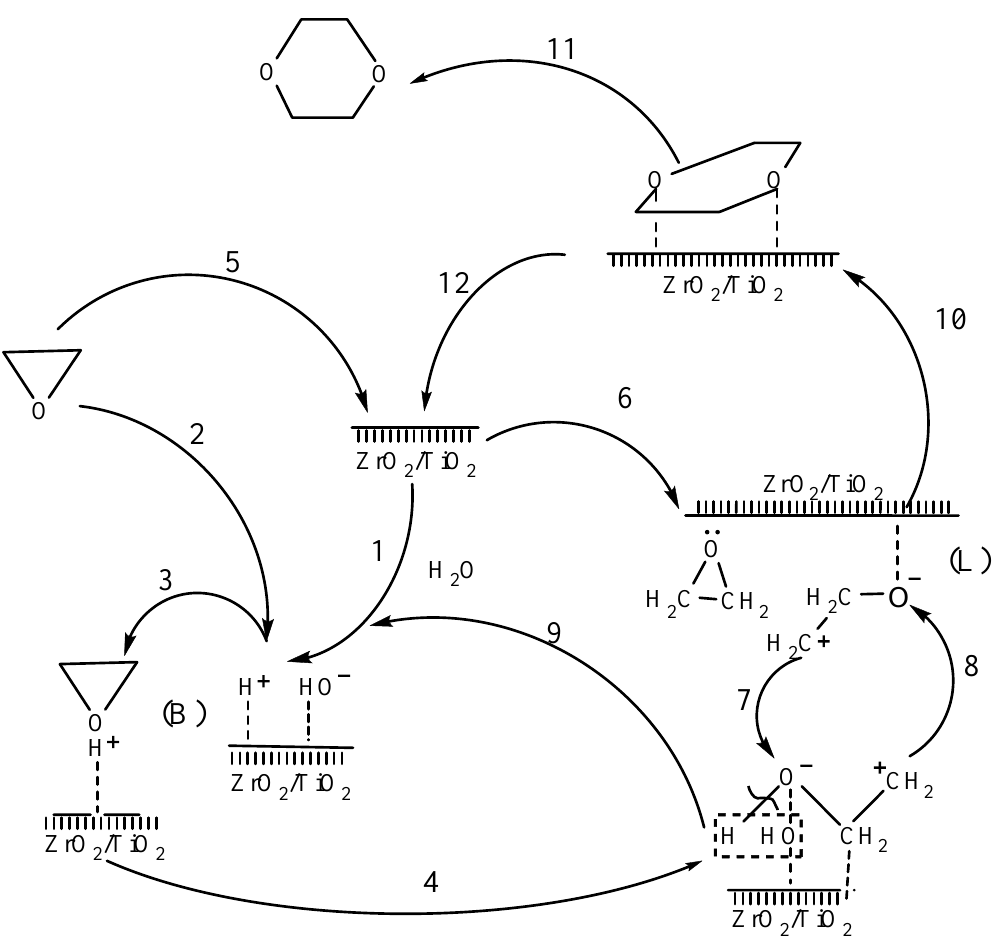
Figure 4. Diagram of synthesis of 1,4-dioxane from ethylene oxide. Table 2. Effect of GHSV.